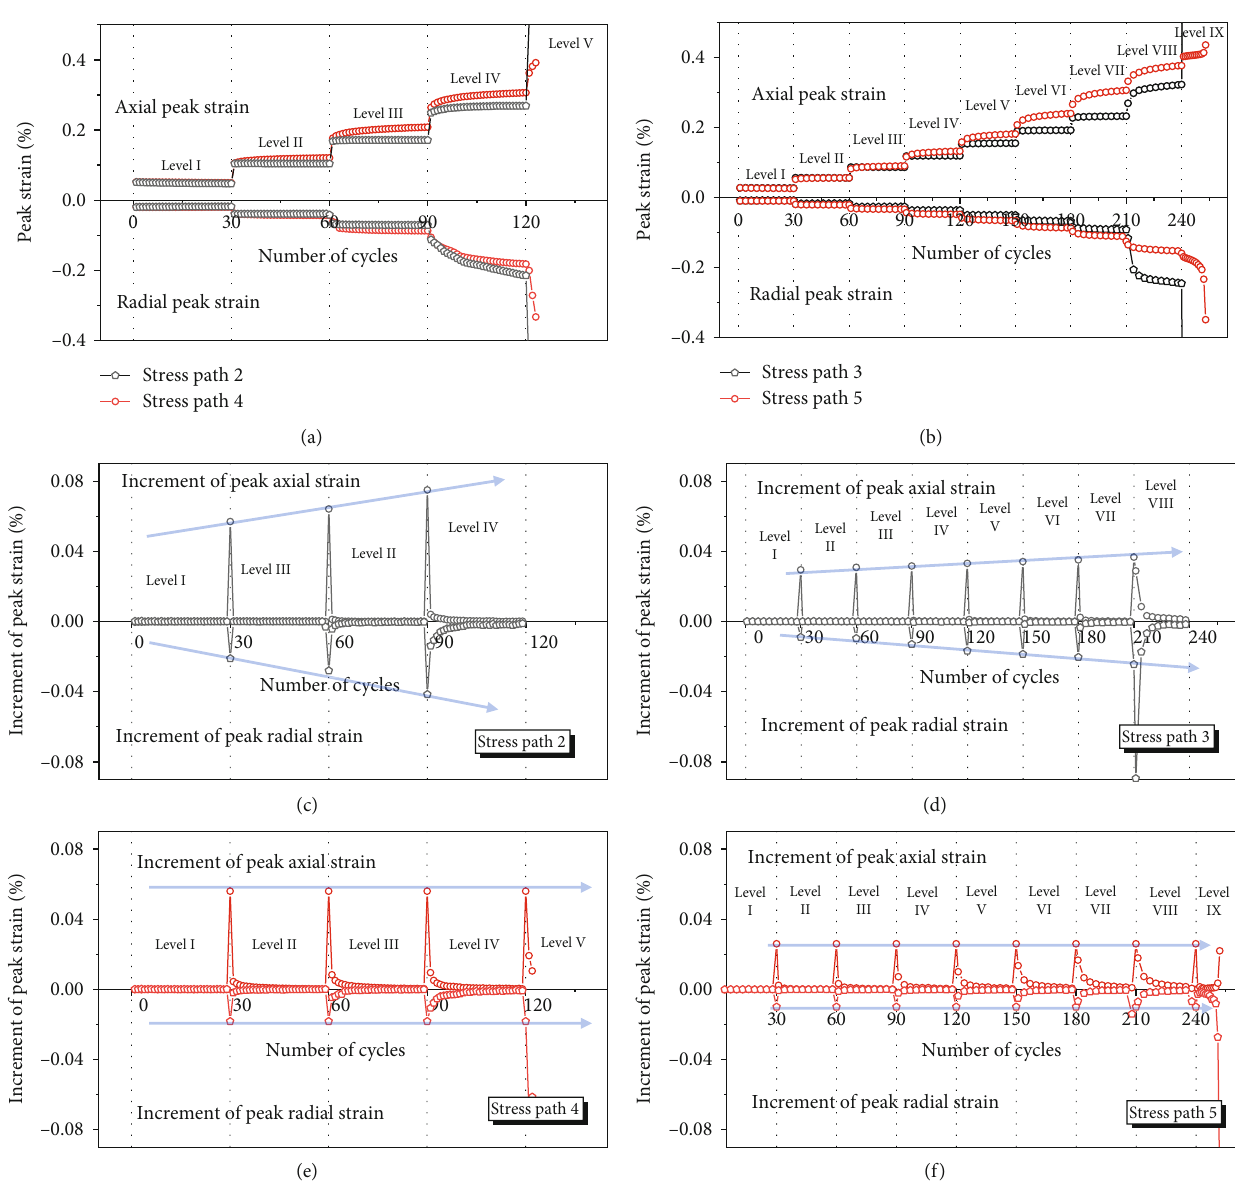
Figure 10: Peak strain of specimen evolution process under di ff erent stress paths. (a) Peak strain evolution with number of cycles under stress paths 2 and 4; (b) peak strain evolution with number of cycles under stress paths 3 and 5; (c) increment of peak strain under stress paths 2; (d) increment of peak strain under stress paths 3; (e) increment of peak strain under stress paths 4; (f) increment of peak strain under stress paths